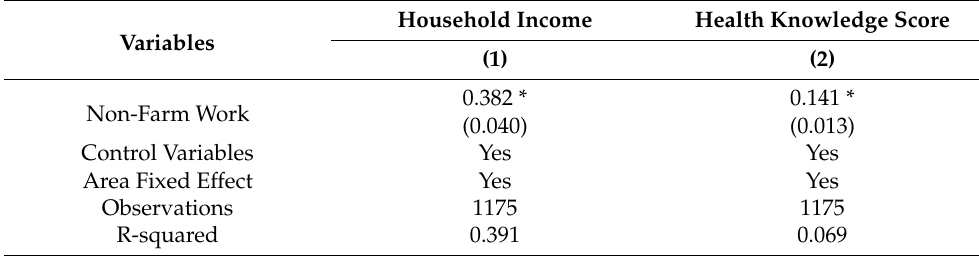
Table 5. Mechanism: Household Income and Health Knowledge